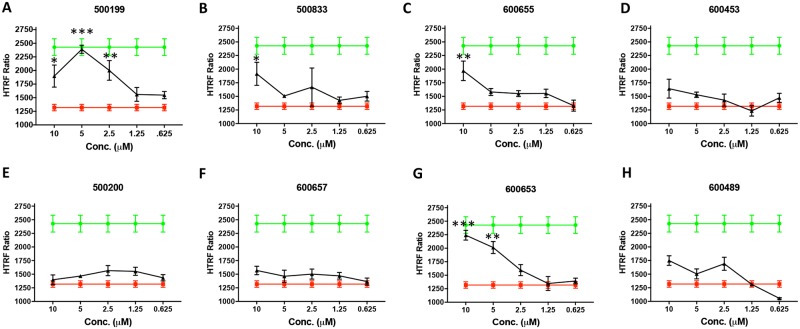
Validation of AMPK pathway activation by phenylbenzamide derivatives in HepG2 cells.A) Cells were seeded at 10,000 cells per well 24 hours prior to treating cells with indicated concentration of compound or DMSO (CTL) for 4 hours. 16μL of cell lysate was incubated with HTRF phospho-AMPK detection reagents and fluorescence emission read at 665nm and 620nm using a PHERAstar platereader. The mean and standard deviation of the HTRF Ratio from three replicate wells is shown. The unstimulated (DMSO) and positive controls lysates are shown in green and red respectively.